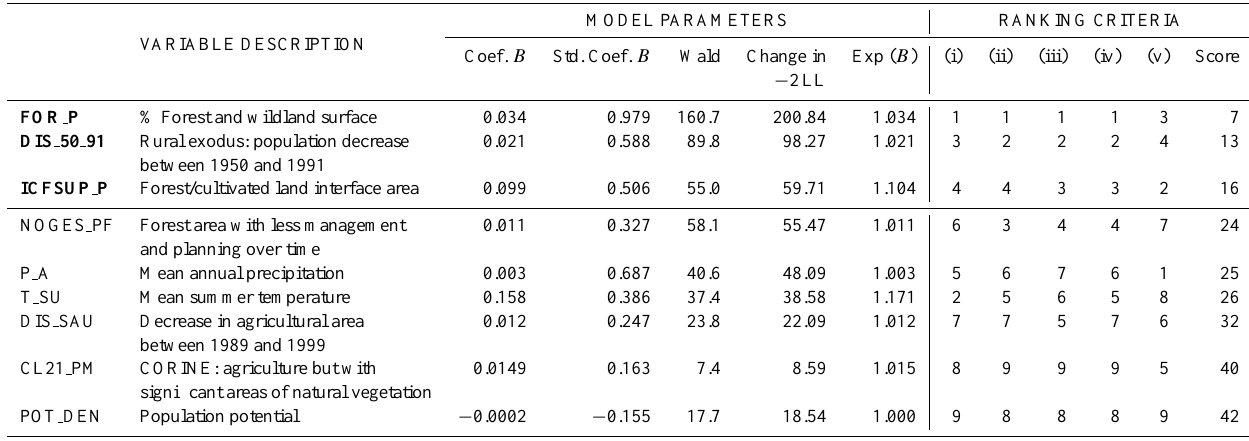
Fig. 1. Map and histograms of dependent variables. Spatial distribution of the fire density in the Spanish municipalities with more than 1 event (A) . The log transformation was applied to convert the original values of the dependent variable (C) to an approximate normal distribution (D) . The map (B) shows the spatial distribution of the municipalities without fires used for the binary logistic modelling. Table 1. Model parameters and sensitivity analysis for ordinary logistic model: ranking of influence of the input variables (the lower the ranks, the more